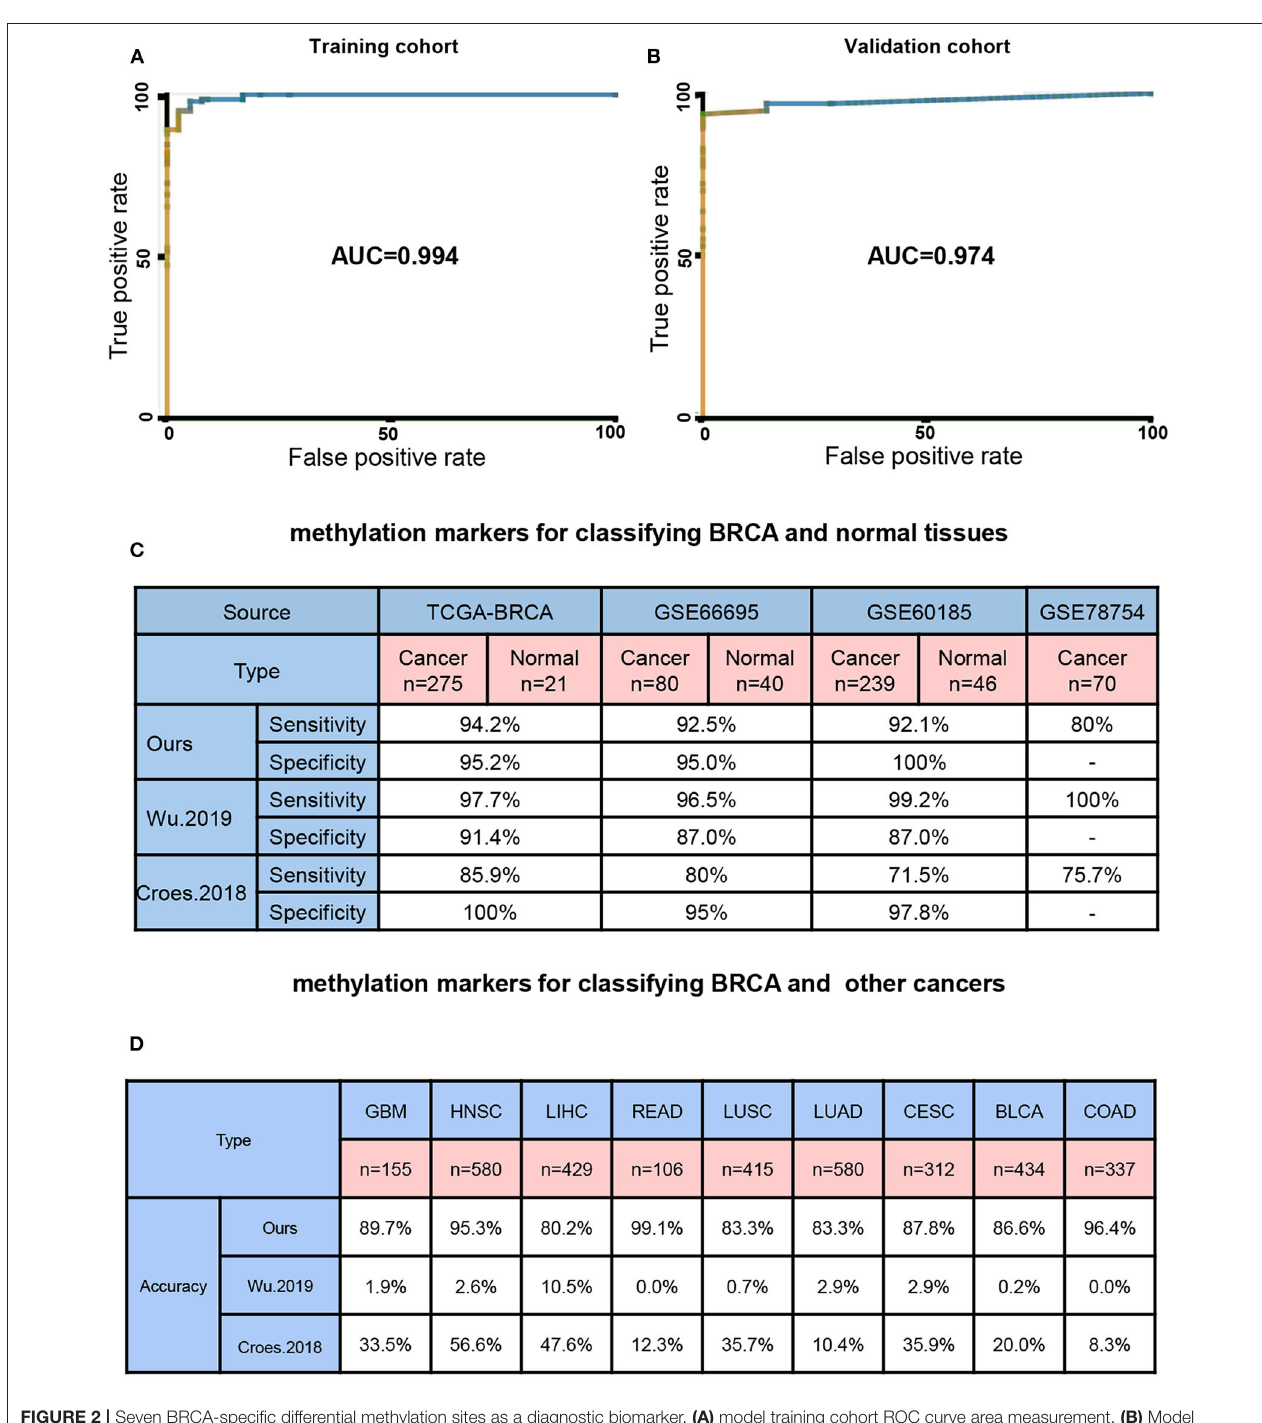
FIGURE 2 | Seven BRCA-specific differential methylation sites as a diagnostic biomarker. (A) model training cohort ROC curve area measurement. (B) Model validation cohort ROC curve area measurement. (C) Four different source sets test the correct rate of the 7 DMSs model and other models. (D) Nine other cancers set test the 7 DMSs model and other models correct